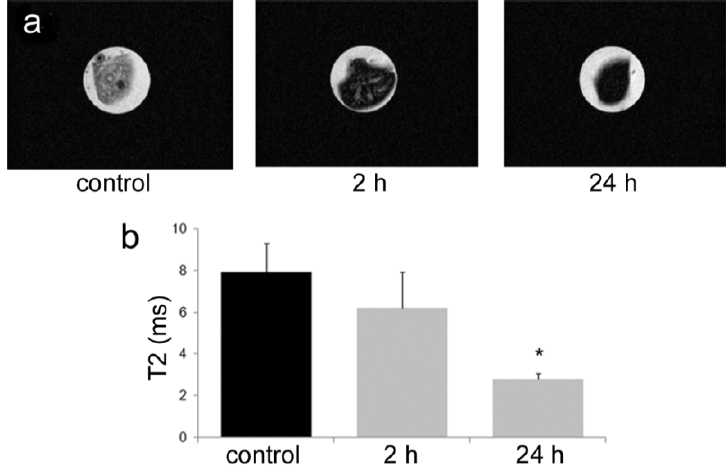
Figure 4. Time-dependent accumulation of intravenously injected SPIONs in the spleen of mice. ( a ) Spleen, recovered from mice at 2 and 24 h post intravenous injection with 20 nm SPIONs, were suspended in agarose phantoms and imaged using a 7T MR